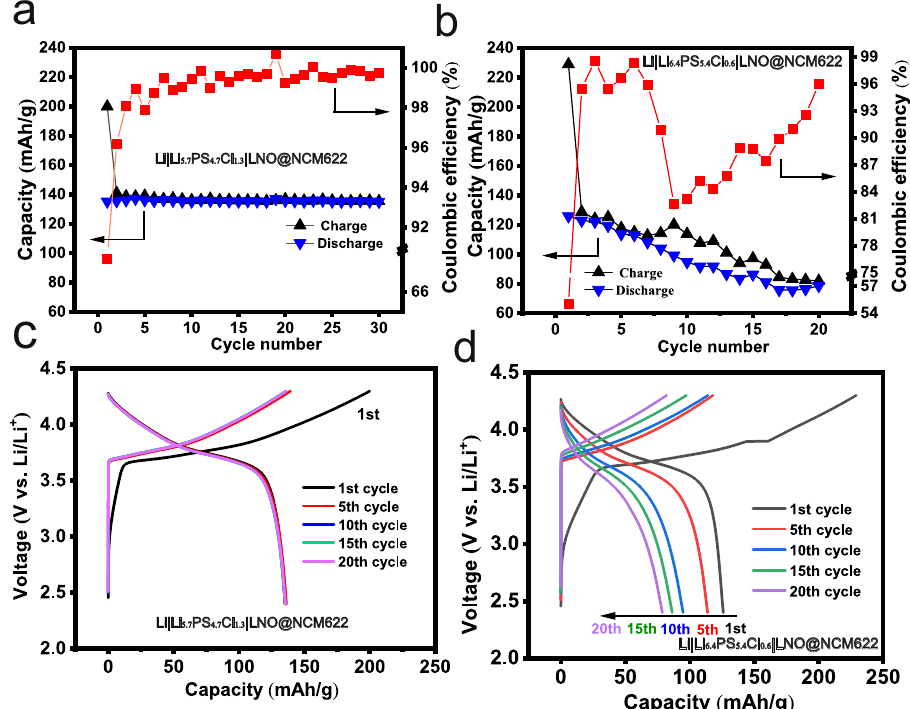
Fig. 6 Electrochemical cycling performance of Li|SE|LNO@NCM622 cells with Cl-06 and Cl-13 SEs. Capacity of Li||LNO@NCM622 cells for the fi rst 30 cycles run at 0.1 mA/cm 2 at 24 ± 4 °C using Cl-06 ( a ) and Cl-13 ( b ) SEs, and the corresponding charge/discharge curves ( c , d